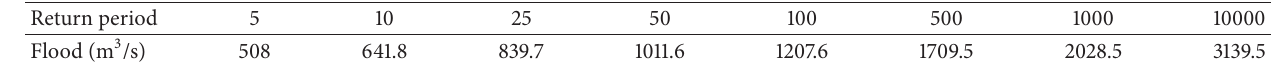
Table 1: Flood values of different return periods of Mert River.